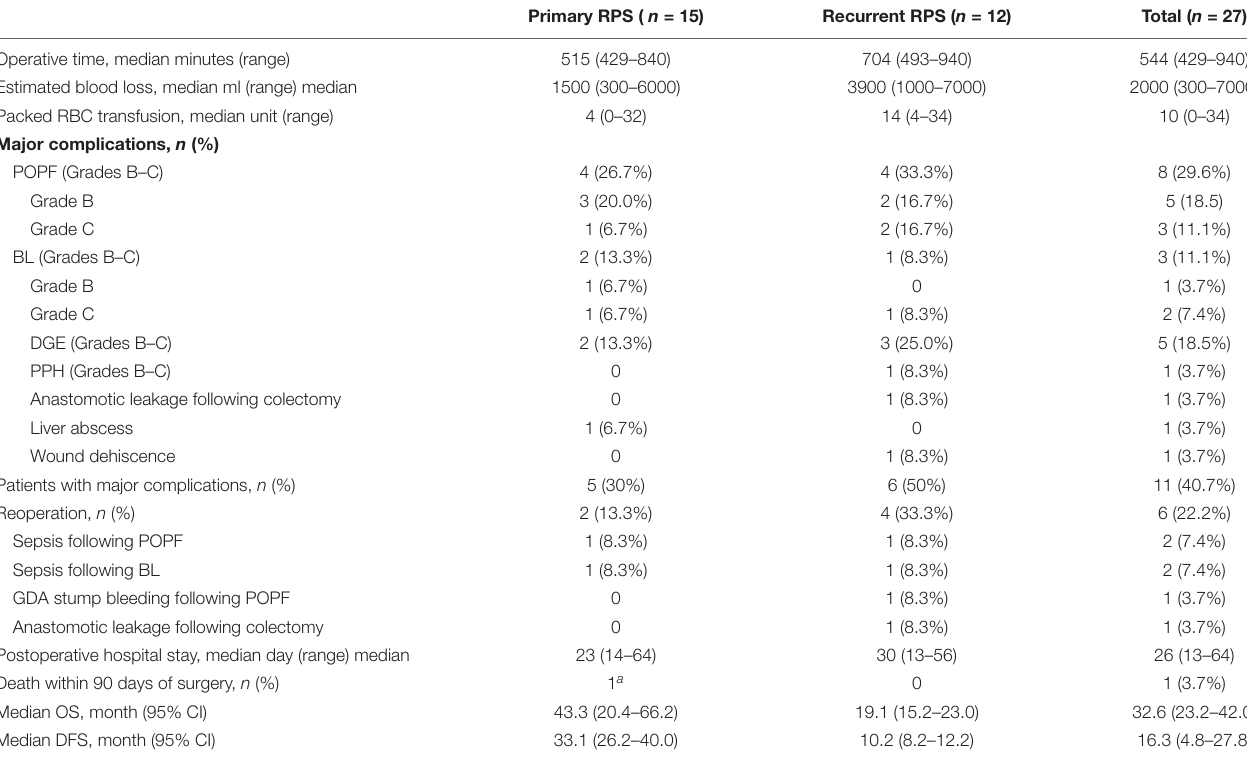
TABLE 2 | Operative data and outcomes.